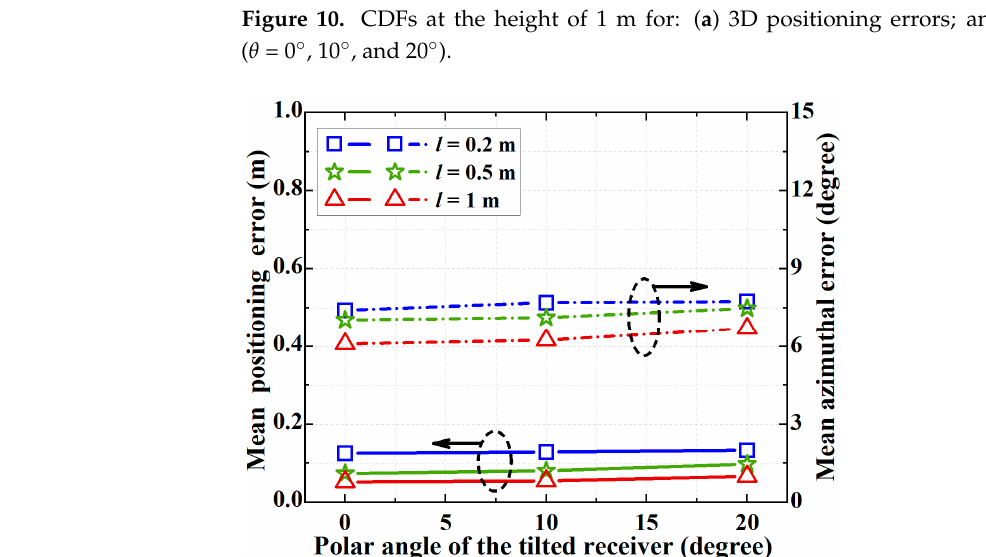
Figure 11. Mean positioning errors and azimuthal errors at the height of 1 m. ( θ = 0°, 10°, and 20°). Finally, based on the test locations in Figure 10, Figure 11 compares the mean posi- tioning errors and azimuthal errors versus different polar angles θ of the tilted receiver.